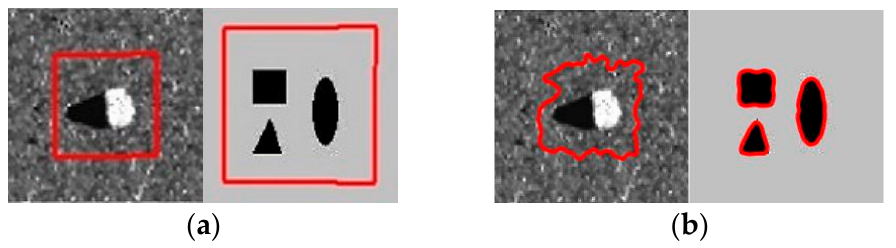
Figure 1. Results in random initialization mode using the DRLSE method. ( a ) Random initial contours; ( b ) segmentation results of DRLSE.